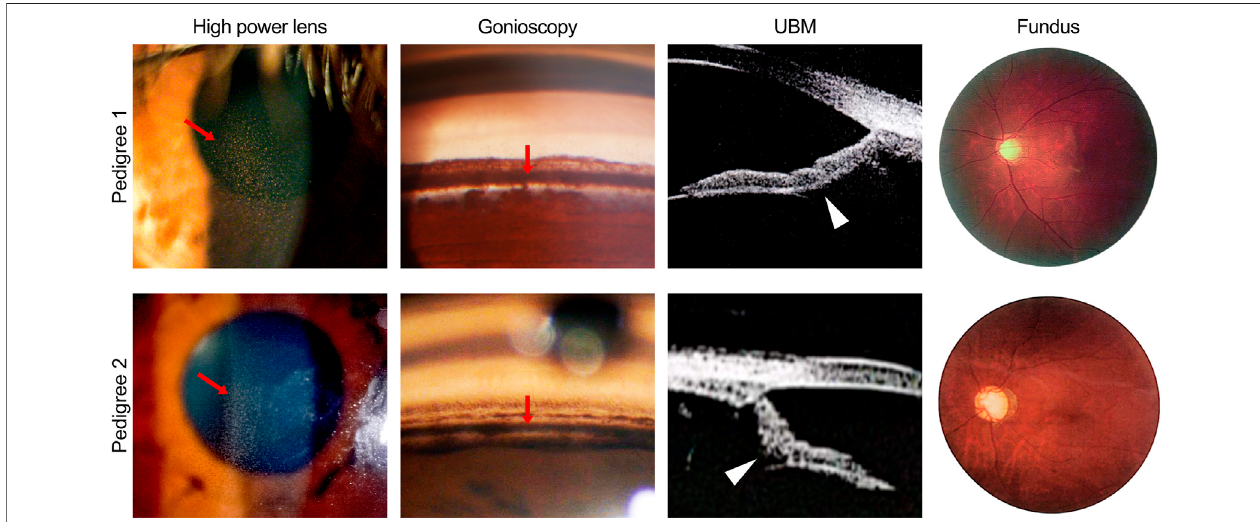
FIGURE1| Ocularphenotypesofpatients intwopigmentary glaucoma(PG)pedigreesassociatedwith CPAMD8 variants.Clinicalphotography includingslit-lamp biomicroscopy, gonioscopy, ultrasound biomicroscopy, and fundus photography. Representative signs of PG, such as Krukenberg ’ s spindle, TM pigmentation, and reversepupillaryblock,wereindicatedbyredarrowsandwhitearrowheads,respectively.Inpedigree1,representativeimageswereacquiredfromtherighteyeofpatient II:5.Inpedigree2,representativeimageswereacquiredfromthelefteyeofpatientII:2(slit-lampbiomicroscopyandfundusphotography)andtherighteyeofpatient II:3 (gonioscopy and ultrasound